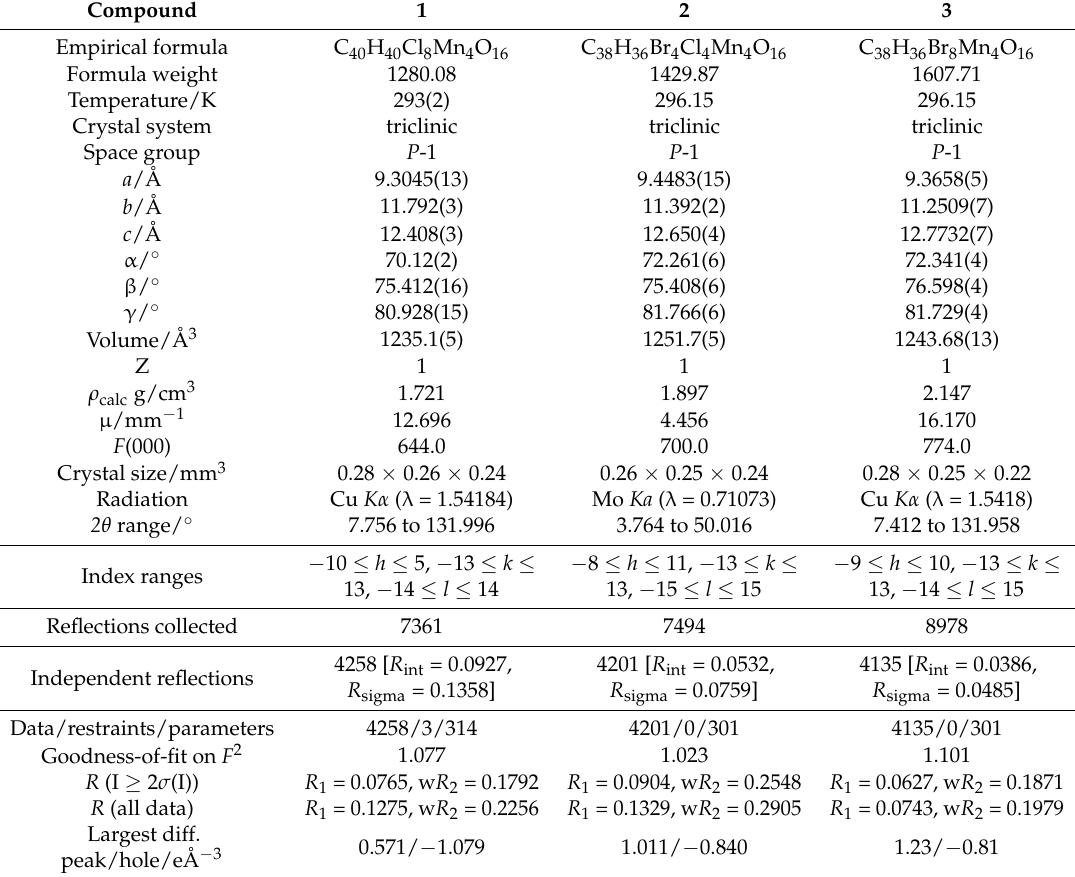
Table 1. Crystal data and structure refinement for Mn III complexes 1 , 2 , and 3